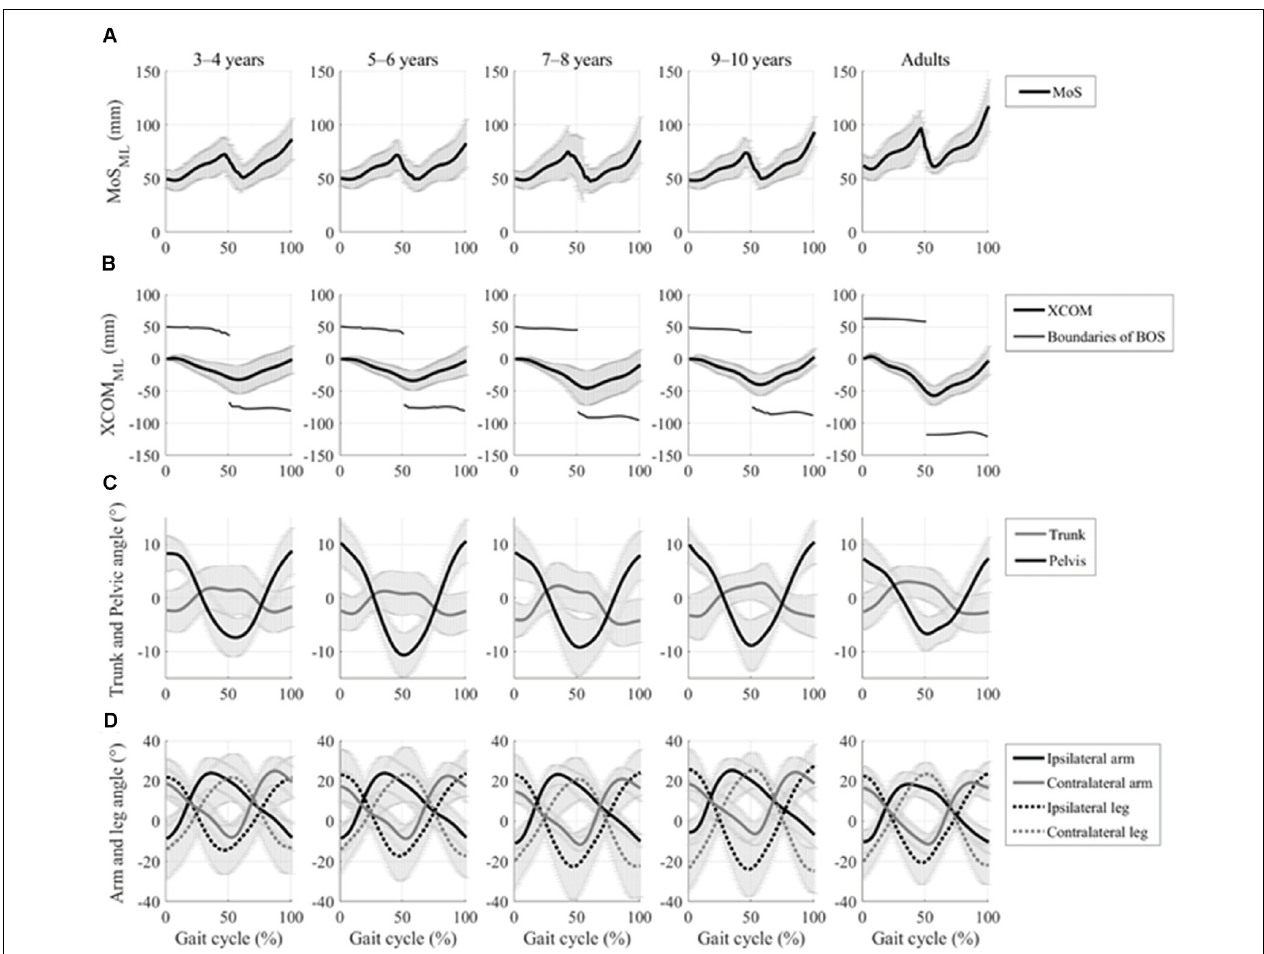
FIGURE 3 | Time profiles of the gait cycle for grand mean spatial margin of stability (MoS), extrapolated center of body mass (XCOM) displacements in the mediolateral axis, and kinematic joint movements with the standard deviation of each group. (A) Grand mean mediolateral margin of stability (MOS ML ) and (B) grand mean mediolateral XCOM displacements (XCOM ML ) and boundaries of base of support (BOS), which is defined by ankle marker on the stance side, and are represented by a thick line and thin line, respectively. (C) Grand mean trunk and pelvic rotational angular movements in the horizontal plane are represented by the gray line and the black line, respectively. (D) The grand mean of both the upper arm and upper leg joint angular movement in the sagittal plane is represented by the solid lines and the dotted lines, respectively. Ipsilateral and contralateral limbs are represented by the black lines and the gray lines,